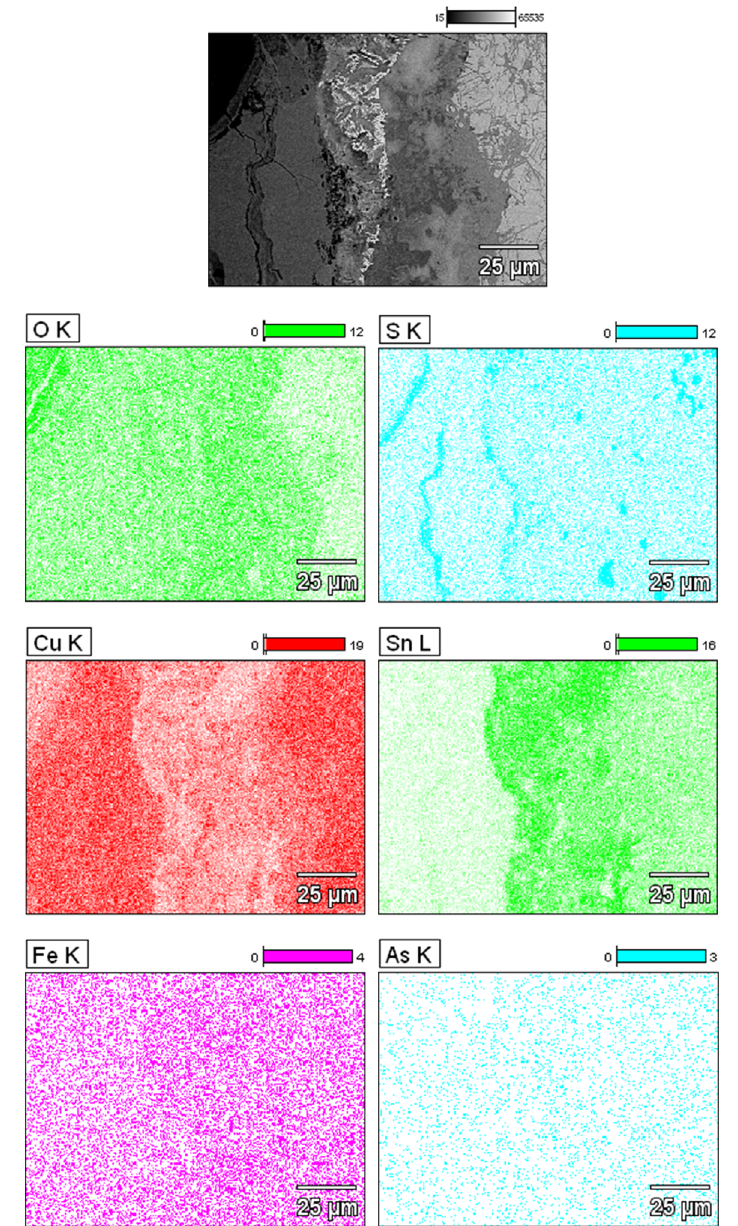
Figure 8. Elemental distribution map, with arsenic and iron, of the specimen sample from the collar (LMN 14147) near Lüne- burg (scan: Dirk Kirchner, German Mining Museum,